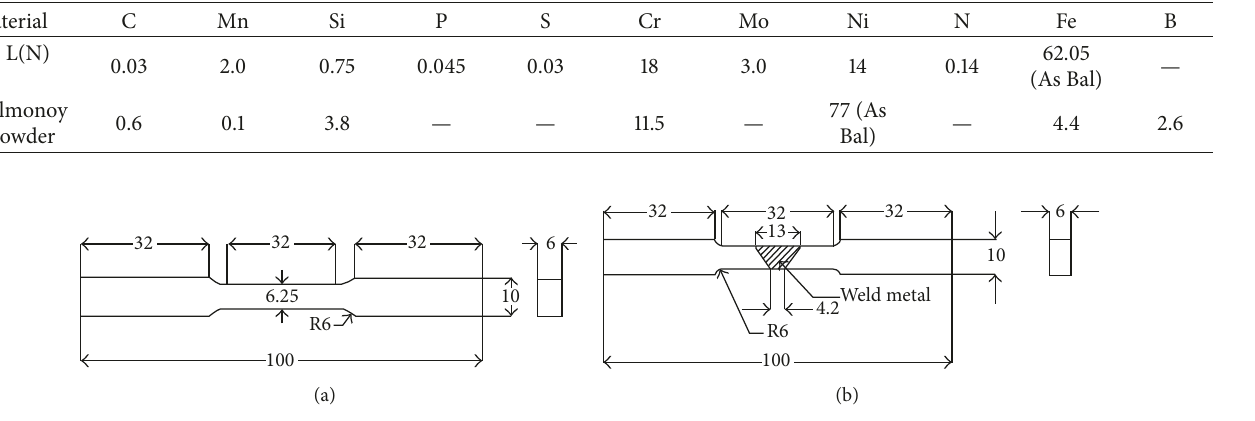
Figure 2: Geometry of (a) patent metal specimens (as per ASTM E8) and (b) weldment specimens (as per ASTM E8 with the weld metal at the centre as per ASME section IX).